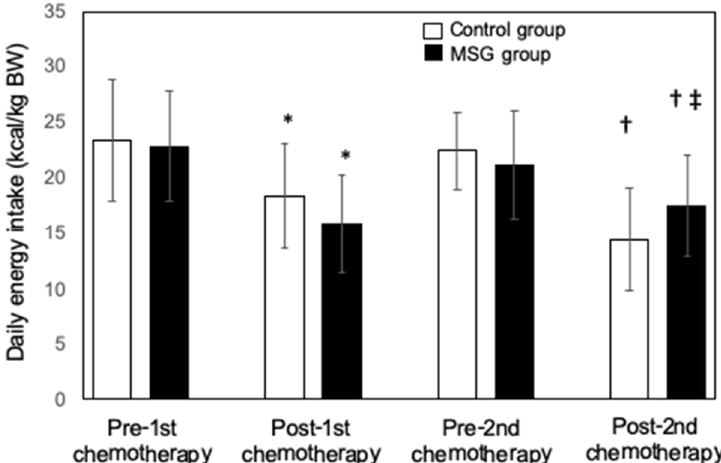
Figure 3. Effect of dietary monosodium glutamate (MSG) supplementation on chemotherapy-induced reduction in daily energy intake in patients with head and neck cancer. Daily energy intake (kilocalories per kilogram of body weight) was measured in patients randomly assigned to the control ( n = 26) and MSG ( n = 25) groups during the week before and the week after the first and second doses of chemotherapy. Data are represented as the mean ± standard deviation. * p < 0.05 vs. the corresponding value for pre-first chemotherapy, † p < 0.05 vs. the corresponding value for pre-second chemotherapy, ‡ p < 0.05 vs. the corresponding value for the control group. Multiple comparison was performed by the Kruskal–Wallis test and two-way ANOVA analysis of variance. If an overall significant difference was detected, the Tukey–Kramer test was applied to identify pairs showing significant